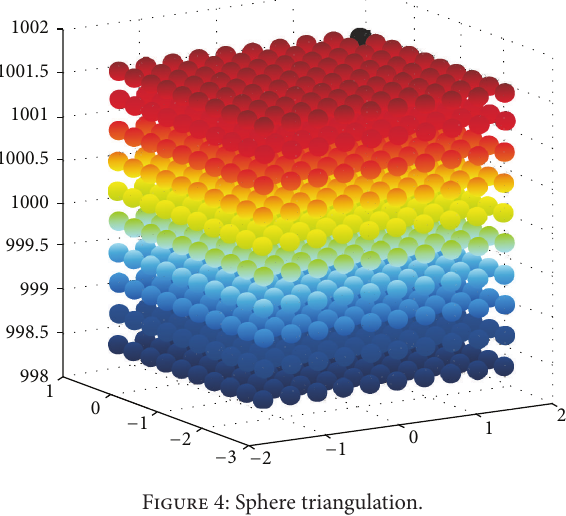
Figure 4: Sphere triangulation.